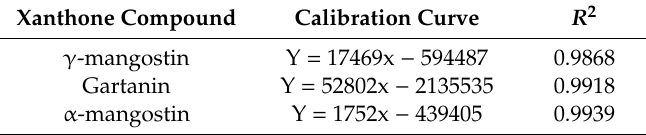
Table 1. Linearity for the quantitation of γ -mangostin (GM), gartanin (GT), and α -mangostin (AM). Xanthone Compound Calibration Curve